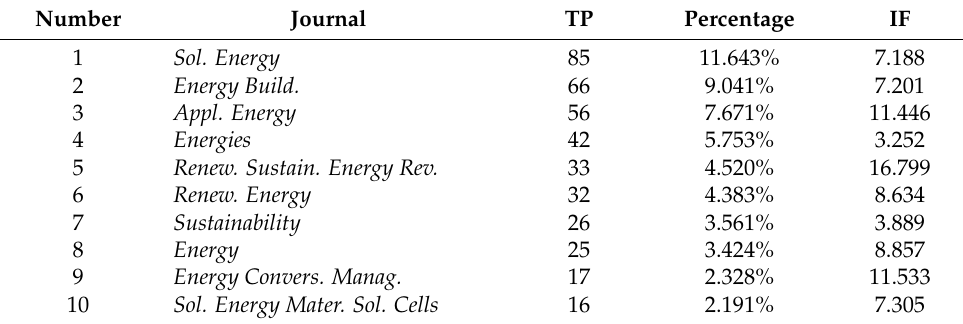
Table 3. The co-occurrence of the top ten journals.